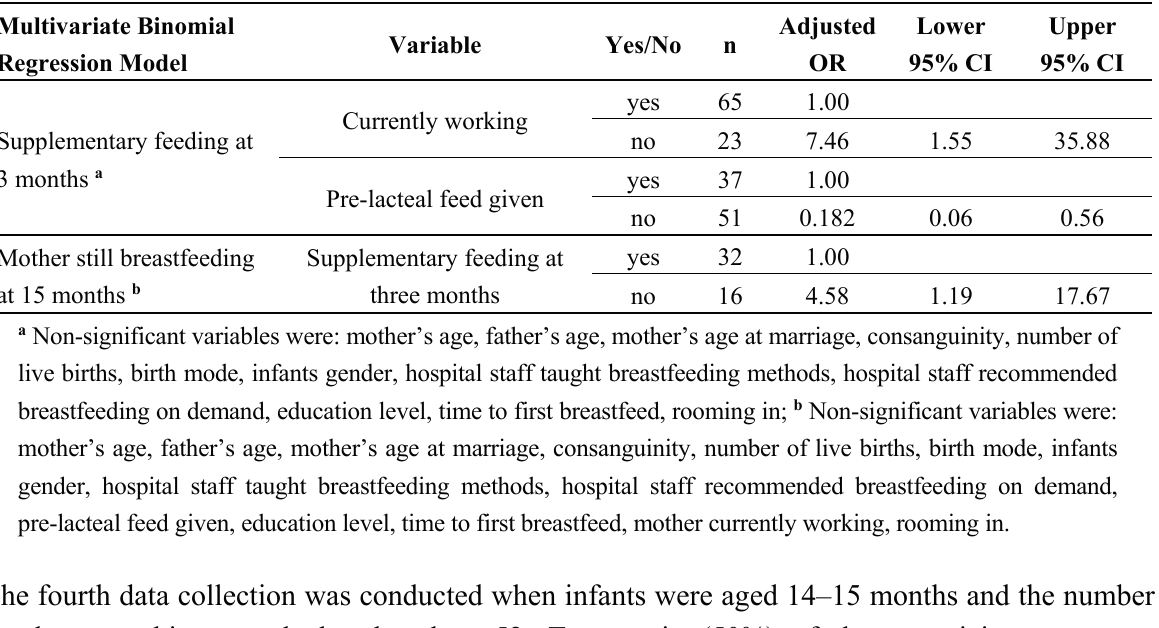
Table 5. Multivariate binomial modelling: factors independently associated with supplementary feeding given at three months and still breastfeeding at 15 months after adjustment for potential confounding